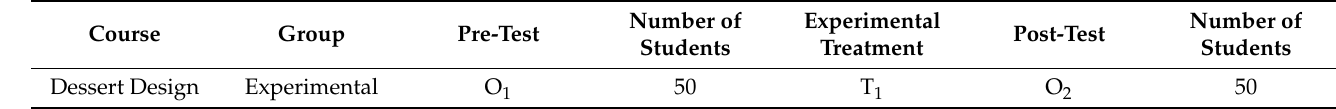
Table 1. Experimental design